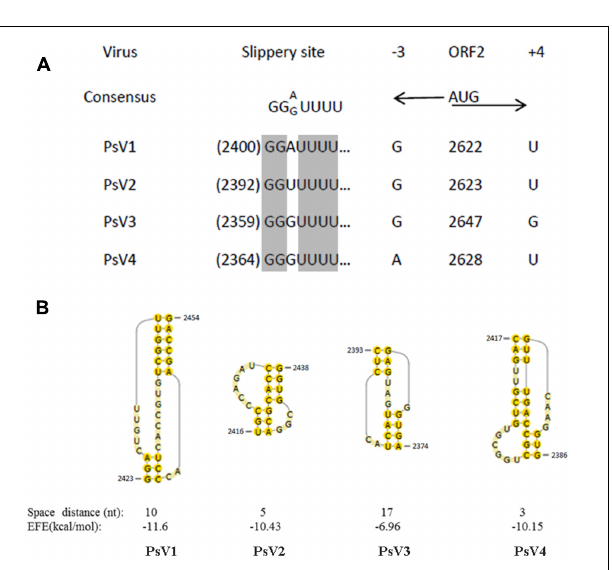
FIGURE 4 | Putative slippery sites and pseudoknot structures predicted in PsVs. (A) The putative slippery sequences (XXXYYYZ) involved in − 1 translational frameshift. The PsVs nucleotide sequences at –3 and +4 relative to the AUG start codon are indicated by black arrows. (B) The predicted pseudoknot structures downstream of the potential slippery sequences for –1 frameshifting are shown by yellow shadow. Spacer distance represents the number of nucleotides between the slippery site and the pseudoknot. EFE (kcal/mol) indicates the minimal free energy. previously with minor modifications (Kondo et al., 2016).